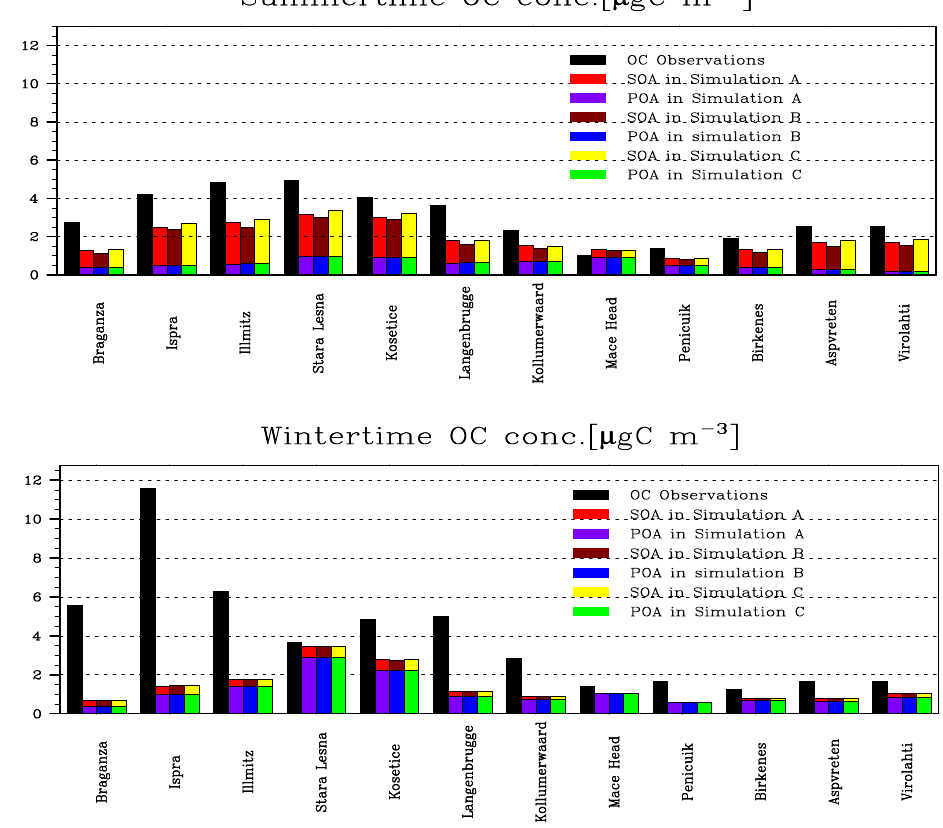
Fig. 6. OC concentrations in summer (July–October 2002 and April–July 2003) and winter (October 2002–April 2003) for 12 rural sites in the EMEP network. y-axis: OC concentration; The x-axis: site names (the sites are ordered according to latitude from the most southern station (left) to the the most northern station (right). Table 8. Comparison of simulated seasonal average carbon concentrations (in µgCm − 3 ) with the observations made in Aveiro and K-Puszta from Gelencs´er et al. (2007) and in Ispra from Gilardoni et al. (2011b). Station Source Winter Summer Name Observation Simulation A Simulation B Simulation C Observations